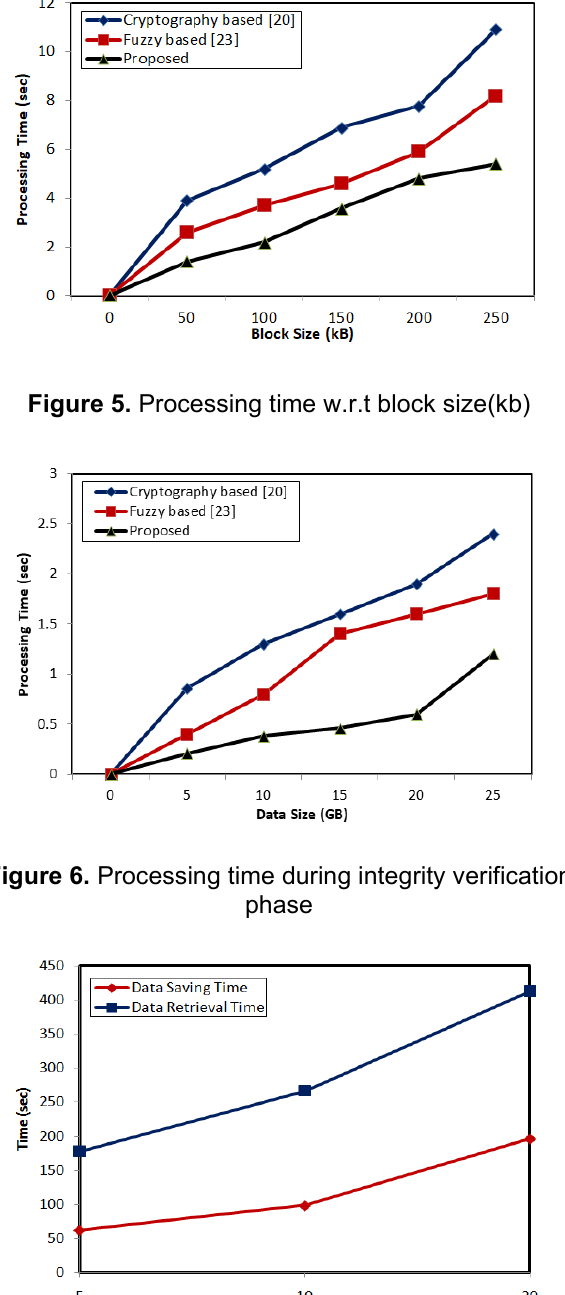
Figure 8. Block insertion operation analysis